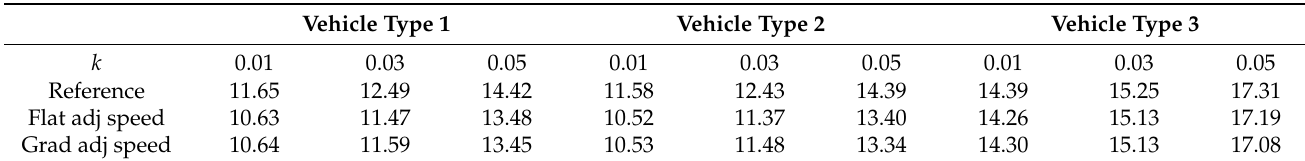
Table 8. Percentage of regenerative energy under alternative speed profiles, gradient assumptions, and vehicle types (symmetric hill, WMTC Reference Cycle